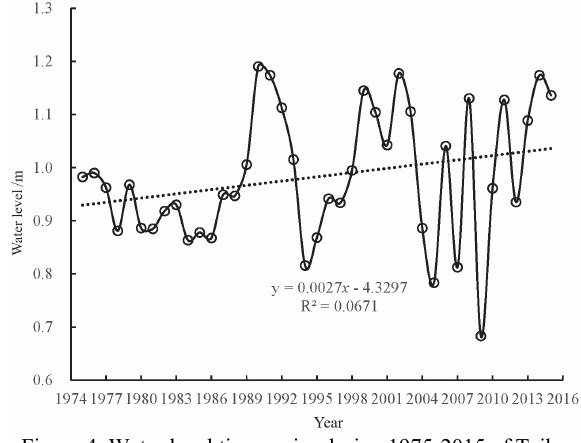
Figure 4. Water level time-series during 1975-2015 of Taihu Lake